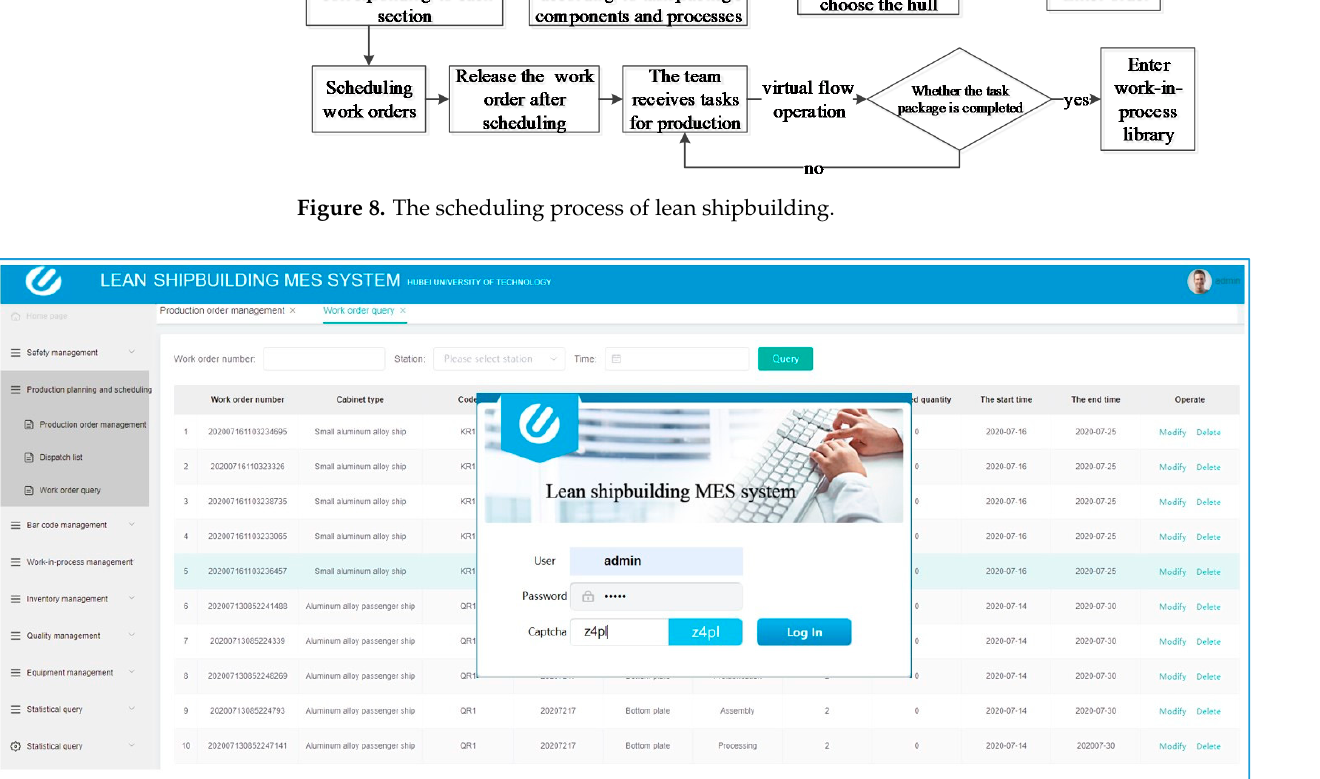
Figure 9. Main interface of lean shipbuilding MES.